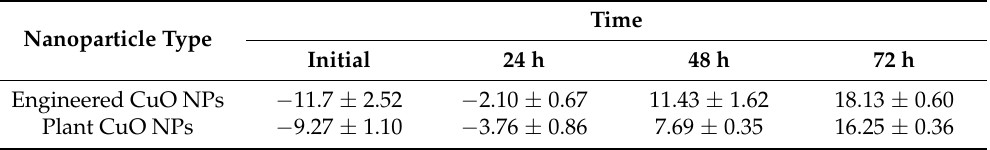
Table 1. Zeta potential of engineered and plant-synthesized CuO NPs.